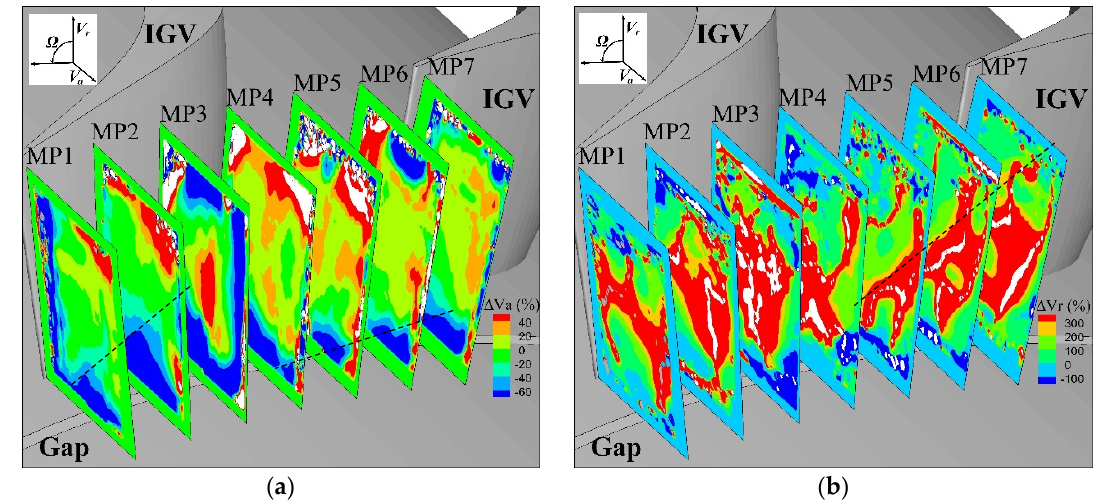
Figure 7. Variation rate of velocity component between Case 2 and Case 1 in the inter-stage flow field. ( a ) ∆ V a ; ( b ) ∆ V r .